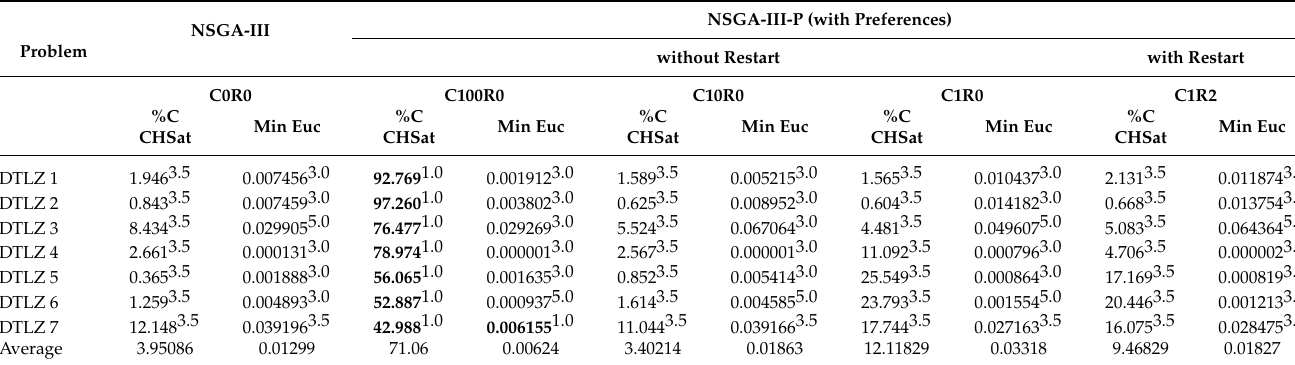
Table 4. Average algorithm performance evaluated with two measures for DTZL problems.